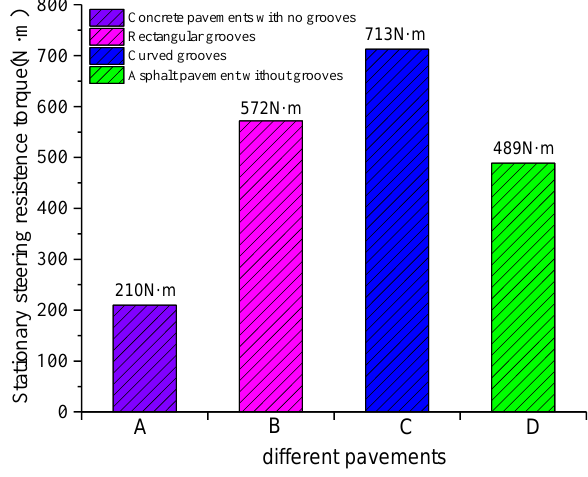
Figure 7. Comparison of stationary steering resistance torque.